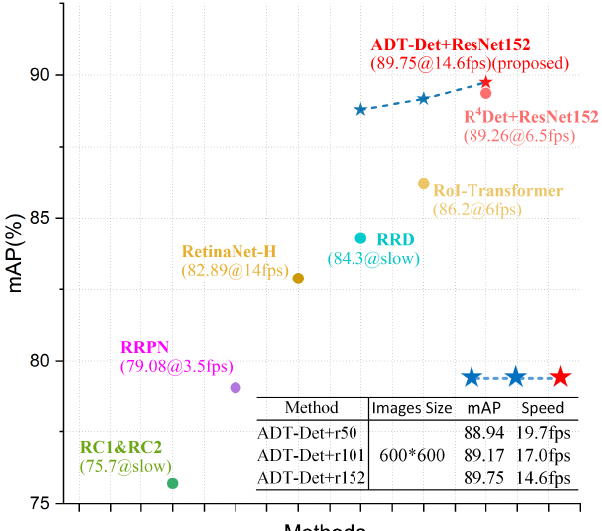
Figure 10. Detection performance (mAP) and speed comparison of our ADT-Det detector and 5 other famous detectors on HRSC2016. Our ADT-Det detector achieved the highest accuracy of all the investigated detectors while running very fast. Detailed results are listed in Table